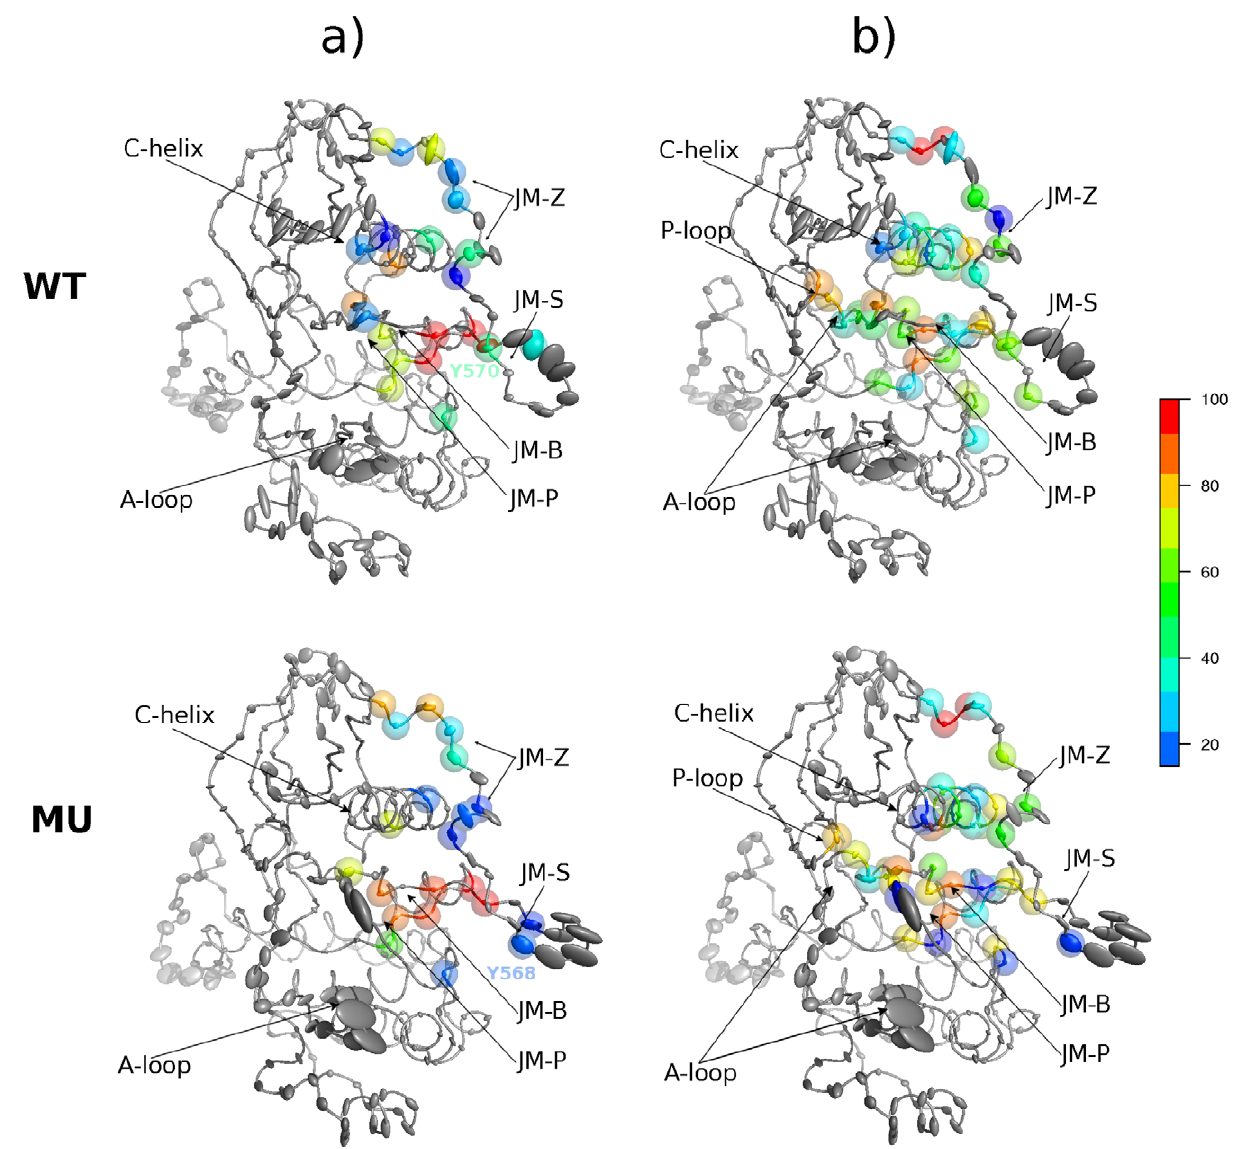
Figure 5. Interaction networks between JMR and PTK in auto-inhibited inactive KIT. Upper Panel: the wild-type, WT 547-935 . Lower Panel: the mutant, MU 547-935 . MD conformations averaged over the simulations 1 and 2 of WT 547-935 and MU 547-935 are represented as grey ribbons. Residues establishing at least one H-bond ( a ) or hydrophobic contact ( b ) between JMR and PTK for at least 15% of the total 96 ns productive simulation time are highlighted with colored transparent spheres. The color code, specified by the color scale bar on the right, goes from dark blue through green to red with increasing occupancy (in percentage of the simulation time). Ellipsoids drawn on C a positions represent the anisotropic atomic fluctuations, computed after RMS fit onto the average MD